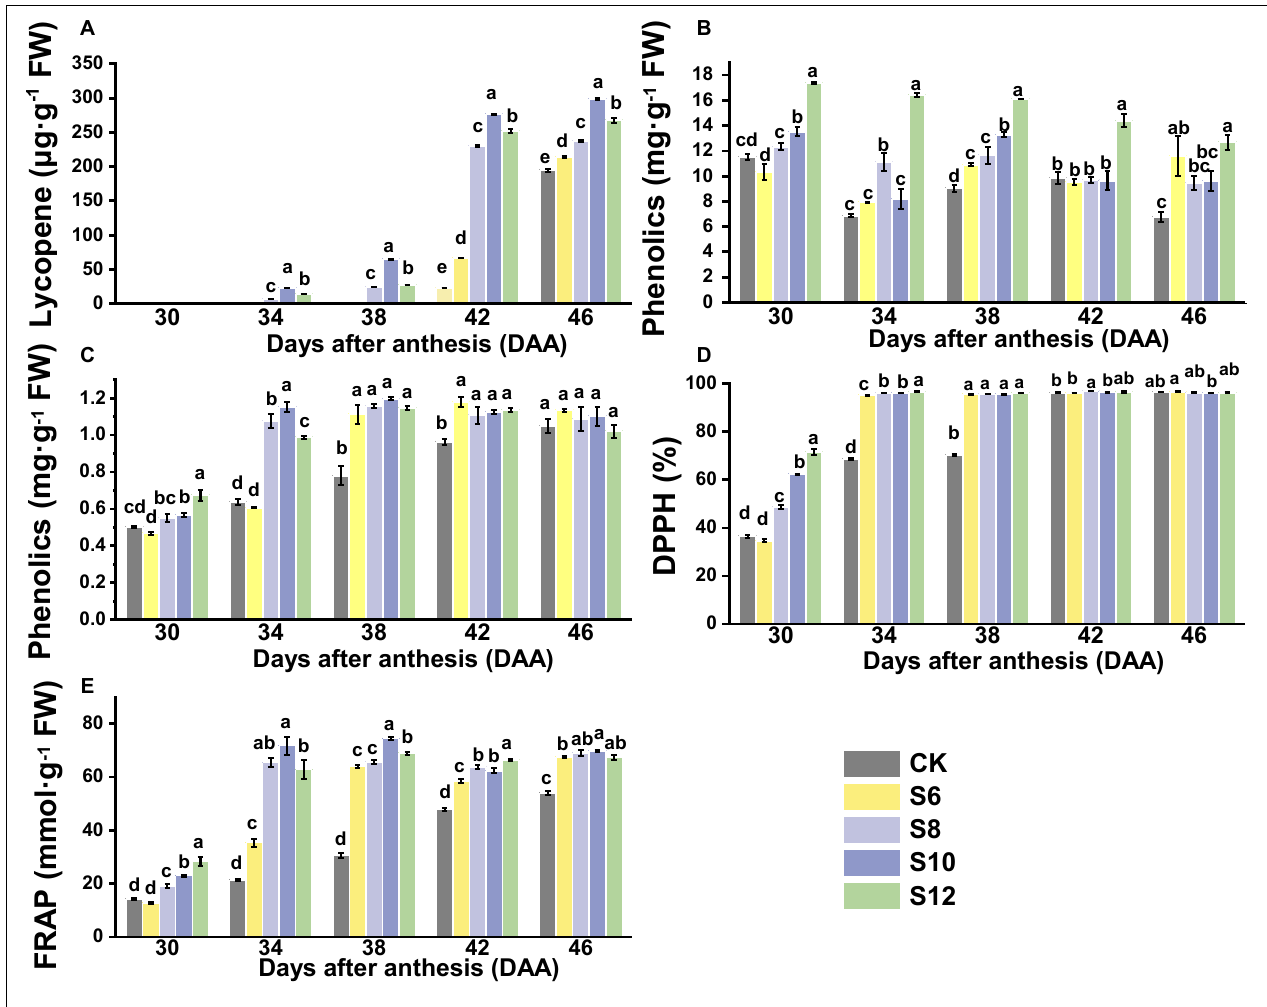
FIGURE 5 | Effects of different supplemental blue light frequencies on the (A) lycopene content, (B) phenolics content, (C) flavonoids content, (D) 2,2-diphenyl-1-picrylhydrazyl (DPPH), and (E) ferric-reducing antioxidant power (FRAP) of tomato fruit. Values are means ± SD ( n = 3). Different letters denote significant differences among treatments at each sampling day after anthesis separately ( p ≤